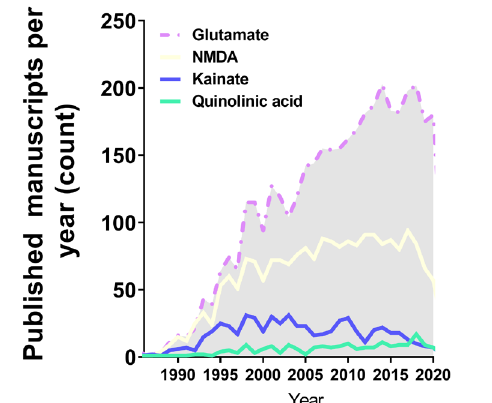
Figure 1. Annual publications in the excitotoxicity field regarding the application of excitotoxicity inducer in in vitro cell models over the years. This search was performed with PUBMED searching tools with its indexed papers, following the request example “((excitotoxicity) AND (in vitro) AND (Glutamate)) NOT (review[Publication Type])”, “((excitotoxicity) AND (in vitro) AND (NMDA)) NOT(review [Publication Type])”, “((excitotoxicity) AND (in vitro) AND (Kainate)) NOT (review[Publication Type])”, “((excitotoxicity)